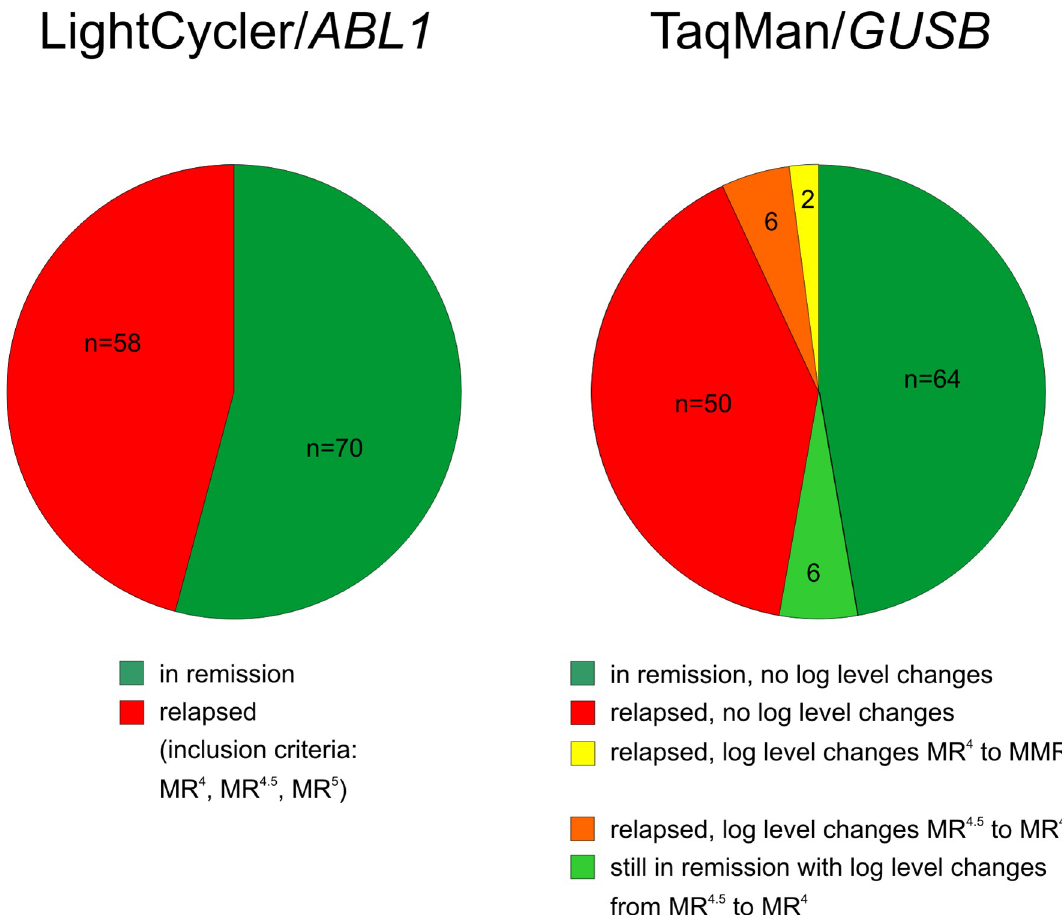
Fig 4. EURO-SKI samples comparatively tested with LC/ ABL1 and TM/ GUSB system. Comparison of EURO-SKI stopping trial interim TFR analysis data (left pie) with a “what if” scenario (right pie) where patient inclusion was based on more sensitive TM/ GUSB instead of LC/ ABL1 assays. Of 128 patients who were evaluated by LC/ ABL1 (left pie), 58 (45%) relapsed within 24 months of TKI discontinuation. According to data based on TM/ GUSB monitoring of 128 EURO-SKI patients (right pie), two of the relapsing patients (2/58 = 3.4%) were re-classified from MR 4 to MMR and, therefore, both specimen analyzed did not meet the inclusion criteria anymore (yellow sector). The same holds true for another 6 patients (6/58 = 10%) when MR 4 was excluded as inclusion criterion (orange sector). Six samples of patients in remission were re-classified from MR 4.5 to MR 4 but are currently still in TFR (light green